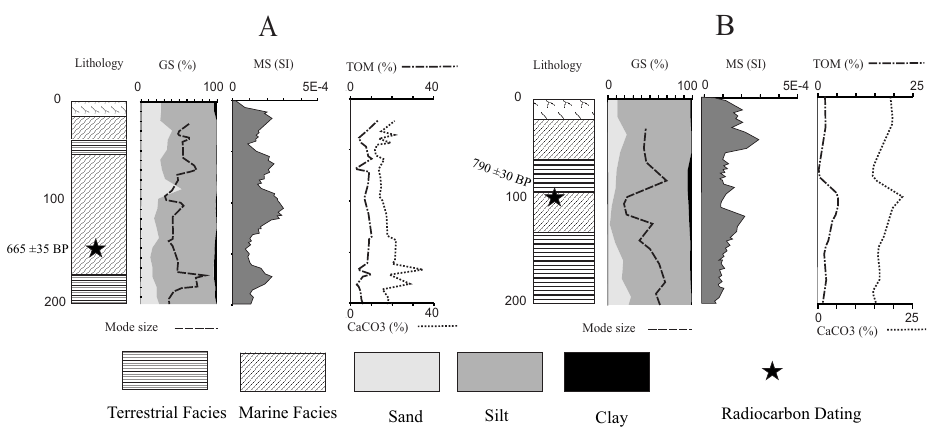
Fig. 4. Lithology of two cores taken near Hassanqoli Bay in the southeast of the Caspian Sea. The position of the cores is presented in Fig. 3. The stars denote the dated horizons and the corresponding radiocarbon ages (BP). GS: Grain Size; MS: Magnetic Susceptibility; TOM: Total Organic Matter. The vertical axis is depth in